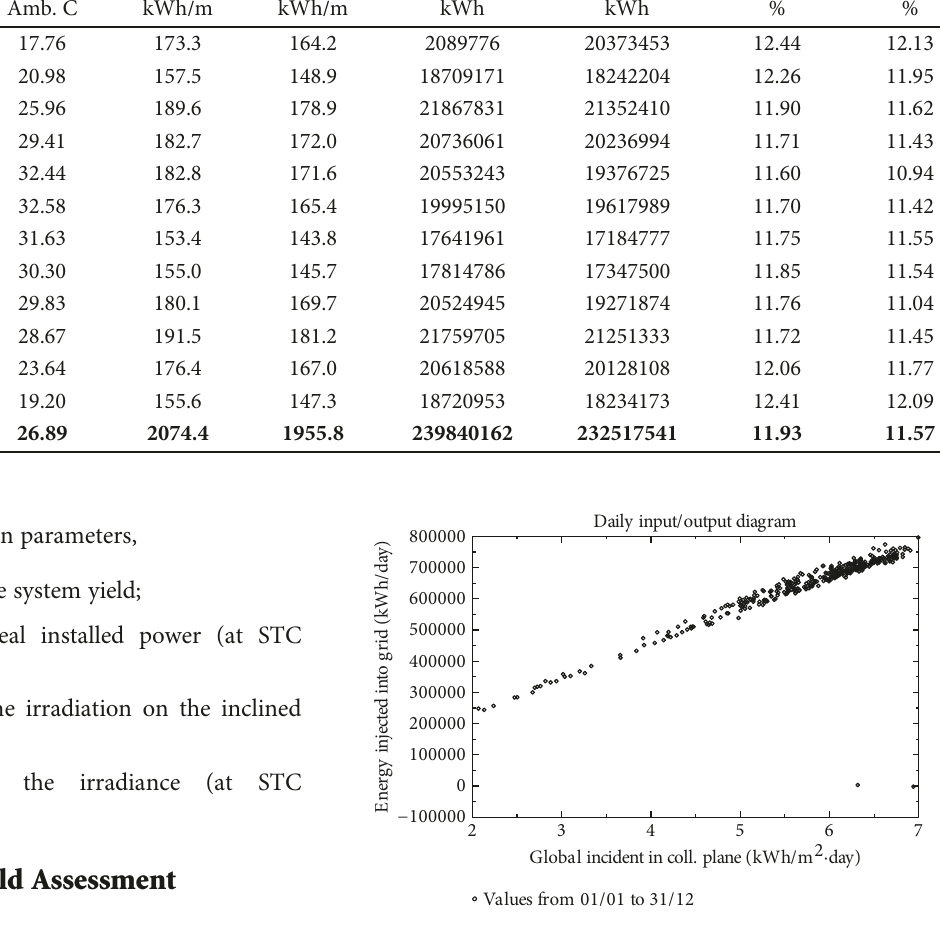
Figure 8: Daily input and output of energy injected into the